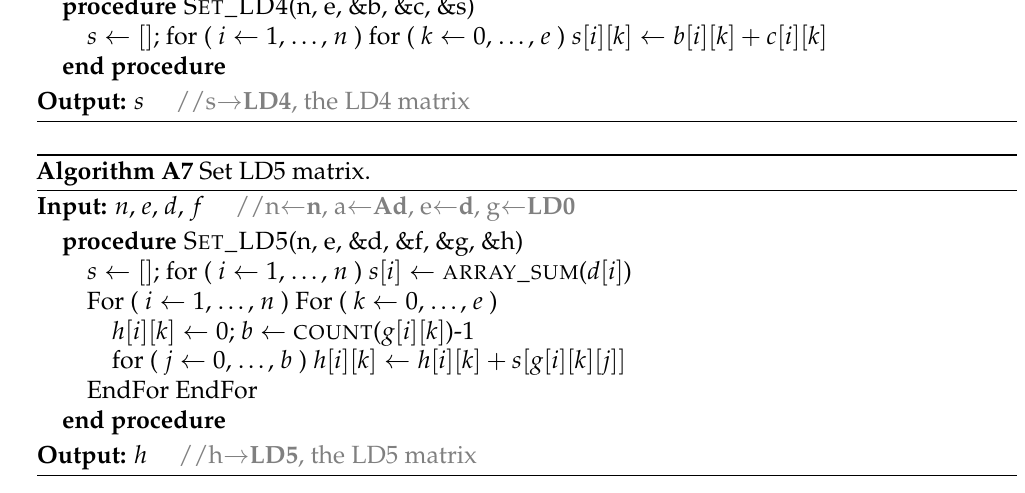
Algorithm A8 Set LkW